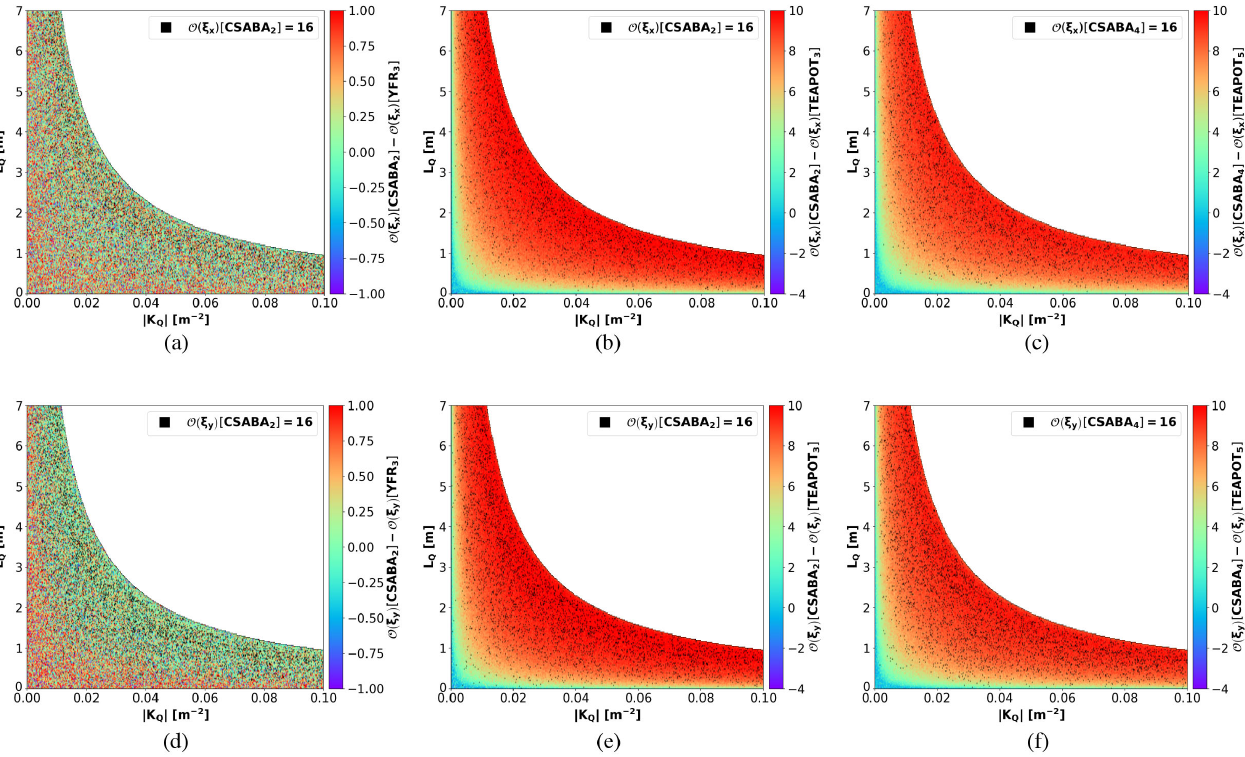
FIG. 3. The difference in order of accuracy of ξ TEAPOT 5 . The difference in order of accuracy of ξ TEAPOT 5 . The combinations of ð K CSABA ν is accurate up to the 16th decimal digit of ξ